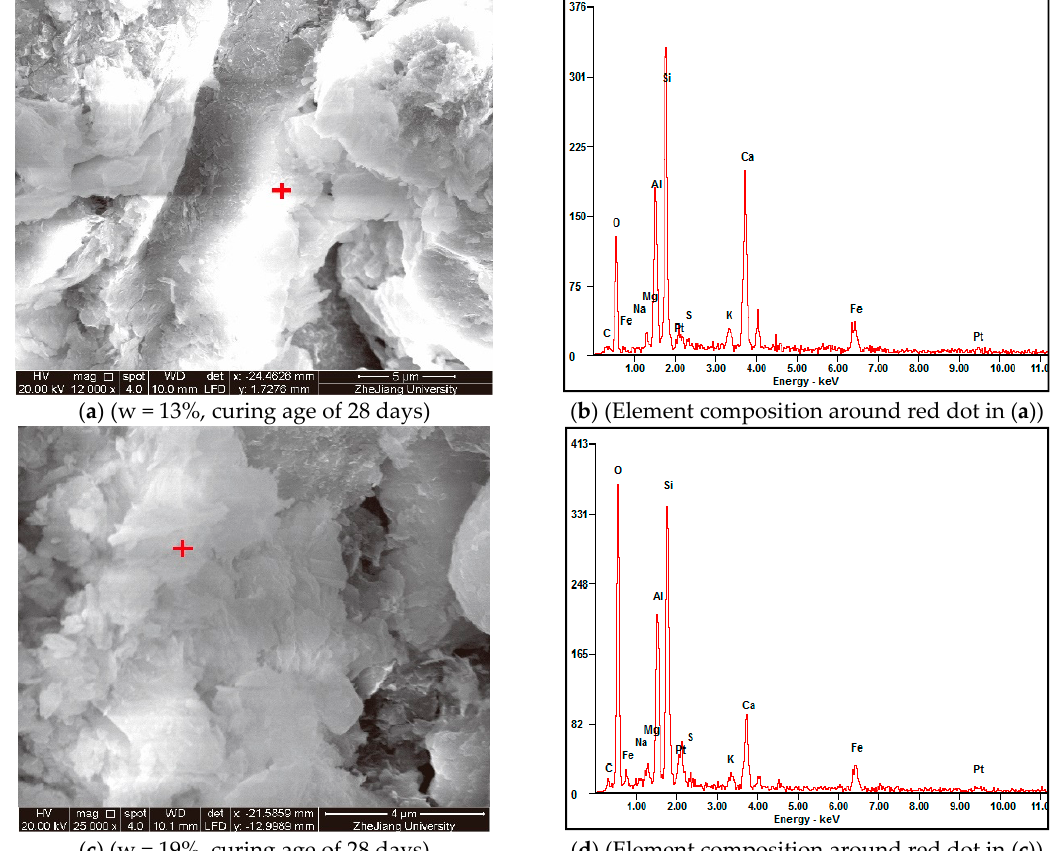
Figure 16. Effects of initial water content on chemical composition.